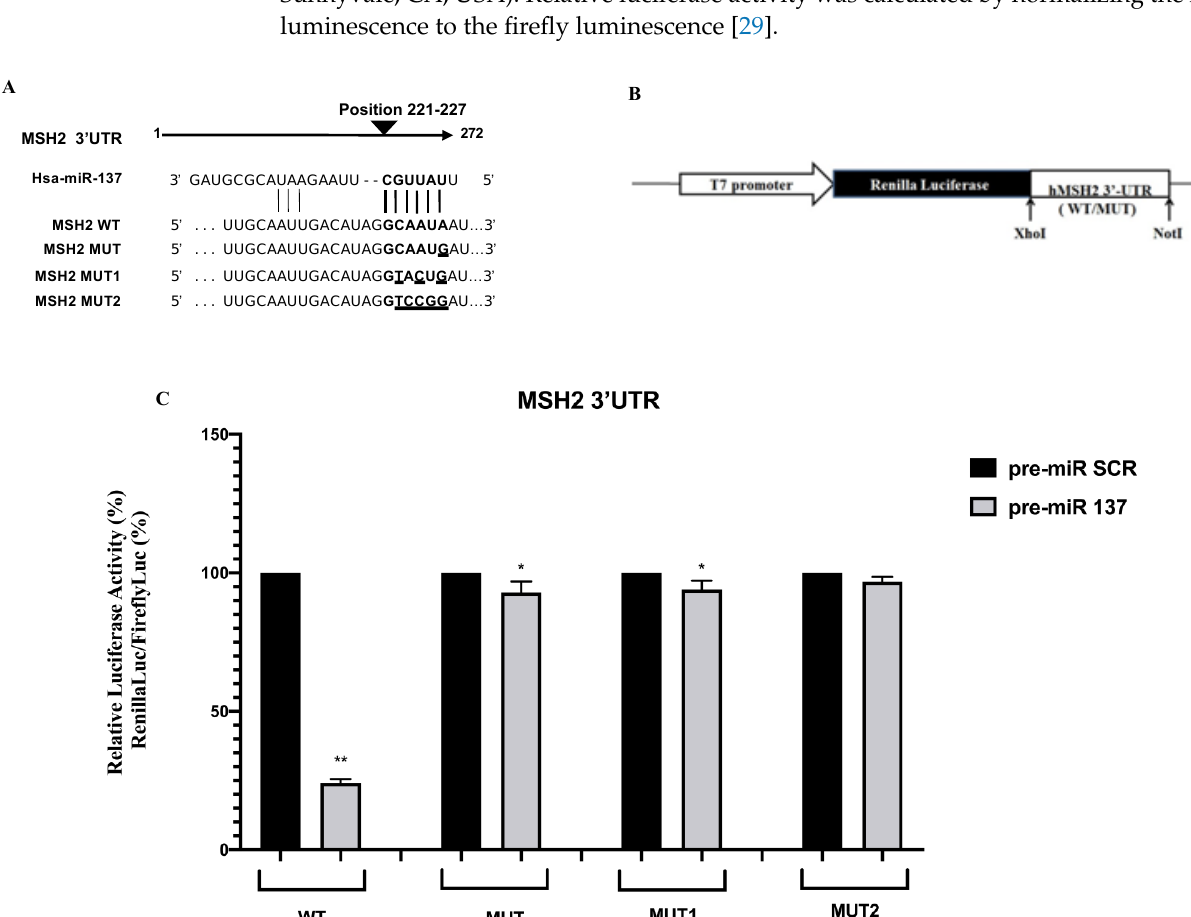
Figure 1. Luciferase MSH2 3′UTR constructs and luciferase reporter assay. ( A ) Wild-type (WT) and mutant MSH2 3′UTR reporter constructs are shown, aligned with the native miR-137 sequence. MSH2 target sequences complementary to the miR-137 seed region are shown in bold and mutated bases are underlined. ( B ) Schematic representation of luciferase reporter gene construct. Constructs were cloned into the PSICHECK2 vector (Materials and Methods). ( C ) Reporter luciferase activity in WT and mutated (MUT, MUT1, MUT2) MSH2 3′UTR was measured in SW480 cells after transfection with pre-miR-137 and pre-miR scramble, (SCR) reagents. Data were normalized to Firefly luciferase activity. Values are expressed in percentages as the mean ± standard deviation (SD) of 4 samples assayed in 3 independent experiments (* p < 0.05; ** p < 0.0001).